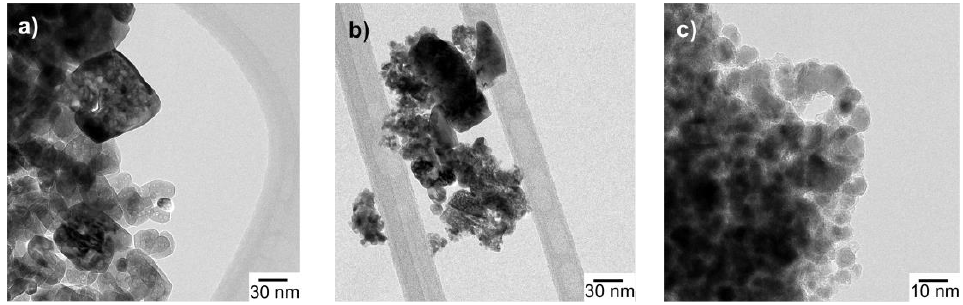
Figure 2. TEM images of ( a ) NiO_air, ( b ) NiO_18%C, and ( c ) NiO_29%C samples.